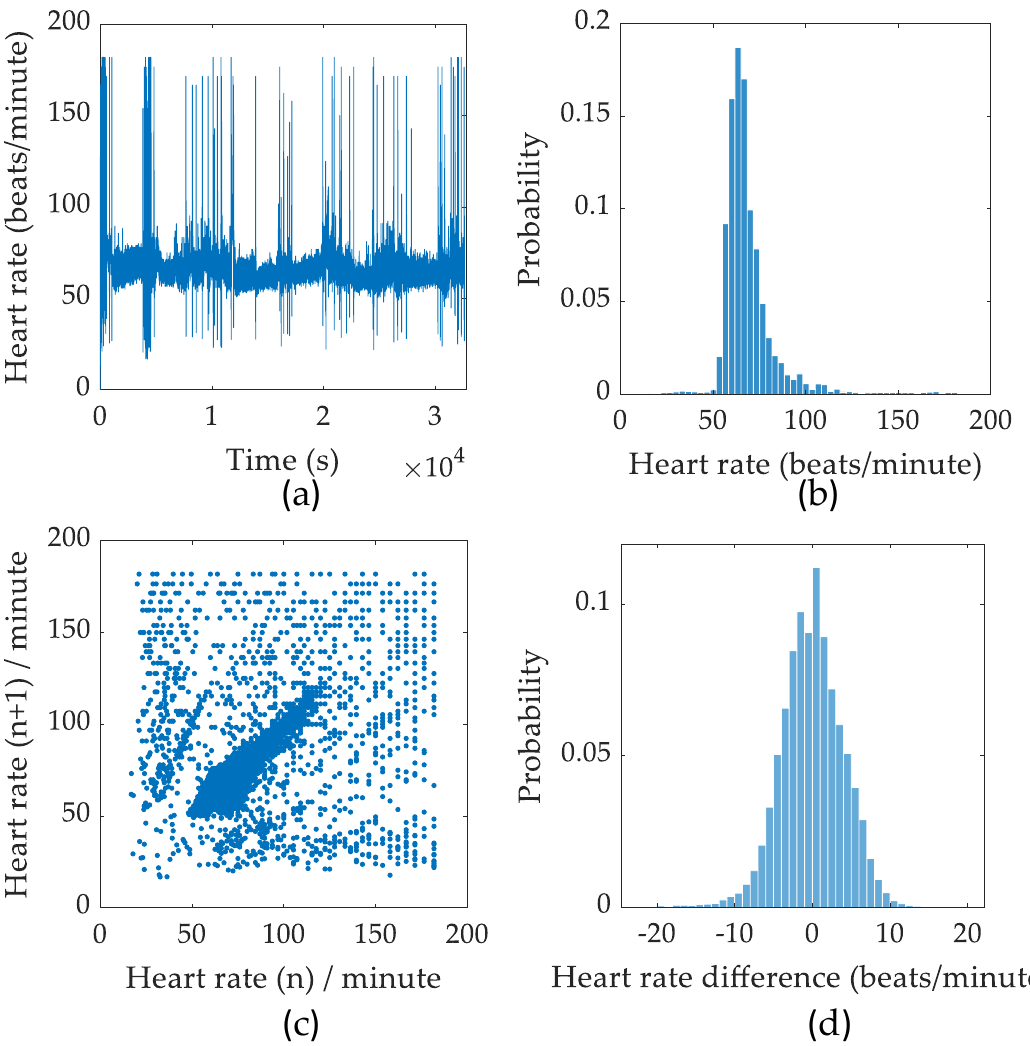
Figure A2. Summary of analysed ECG recordings. ( a ) Beat-to-beat heart rate variation. ( b ) Histogram of heart rate and corresponding probability. ( c ) Poincare plot of n th heartbeat against (n + 1) th heartbeat. ( d ) Histogram of heart rate difference.